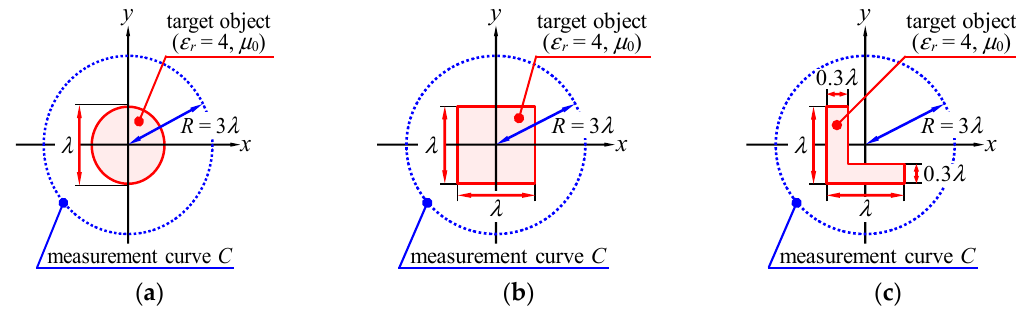
Figure 4. Shape of target object: ( a ) cylinder, ( b ) square, and ( c ) L-shape.